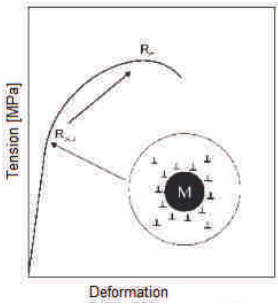
Fig. 5. Schematic presentation of the extension curve [5]